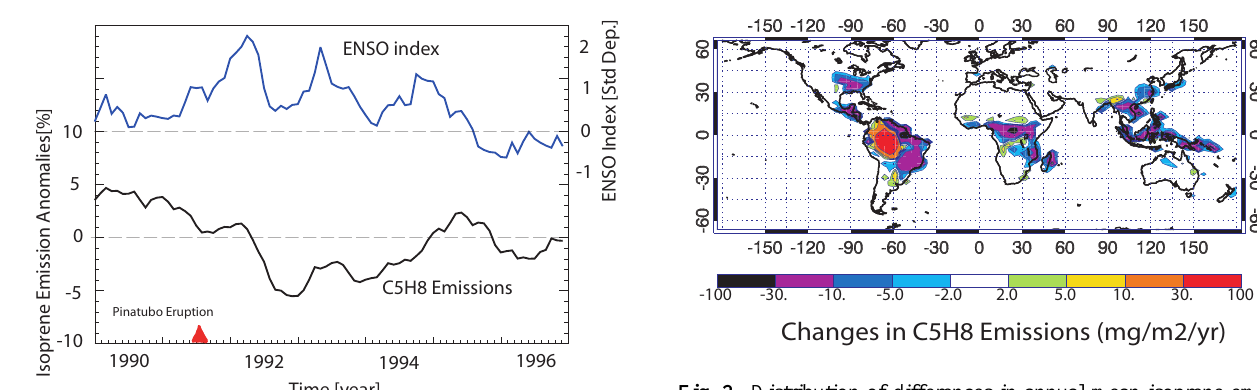
Fig. 2. Distribution of differences in annual mean isoprene emis- sions before and after the eruption of Mt. Pinatubo